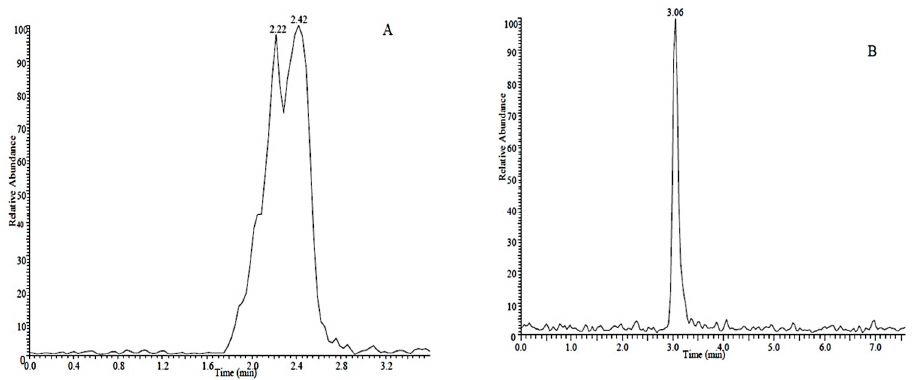
Figure 1. Chromatograms of 6-chloronicotinic acid using reverse phase LC and detection in negative ion mode in the ( A ) absence and ( B ) presence of 0.1% acetic acid as counterion. Olefin imidacloprid displayed high level detector responses in positive modes but the [M − H] − molecular ion peak was greater and more symmetric in the negative ion mode (Figure